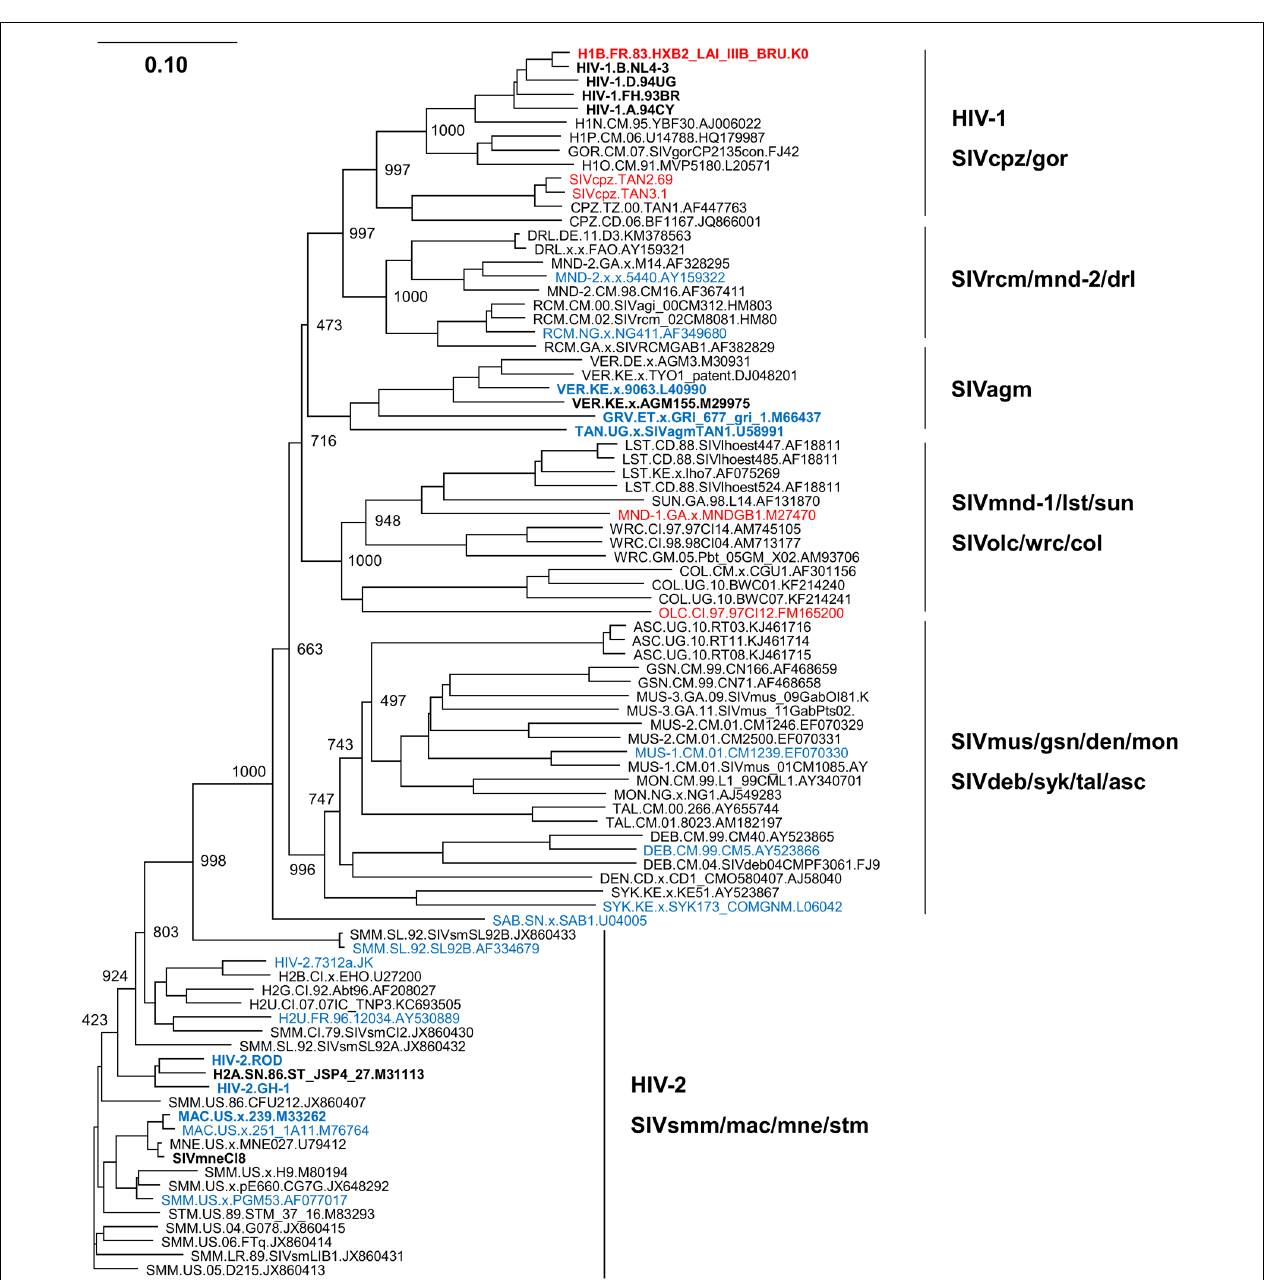
FIGURE 2 | Phylogeny of reverse transcriptase (RT) proteins derived from various HIV/SIVs. Phylogenetic tree based on diverse RT proteins was constructed as previously described (Sakai et al., 2016), and is shown together with SAMHD1-degrading and RT activities. Viral clones with/without SAMHD1-degrading activity (Laguette et al., 2012; Lim et al., 2012) are indicated by blue and red letters, respectively. In addition, viral clones experimentally tested for RT activity (Lenzi et al., 2014, 2015) are indicated by boldface type letters. Note that RT proteins from the HIV-1 group show a higher enzymatic activity relative to those from the other viral groups examined (Lenzi et al., 2014, 2015). Branches were calculated from 1000 bootstrap replicates, and the bootstrap values are labeled on the major branches. Scale bar represents the genetic distance. For virus designations, origins, and types, see the text (Introduction). Amino acid sequences were obtained from the HIV sequence database at Los Alamos National Laboratory (http://www.hiv.lanl.gov) or from the GenBank